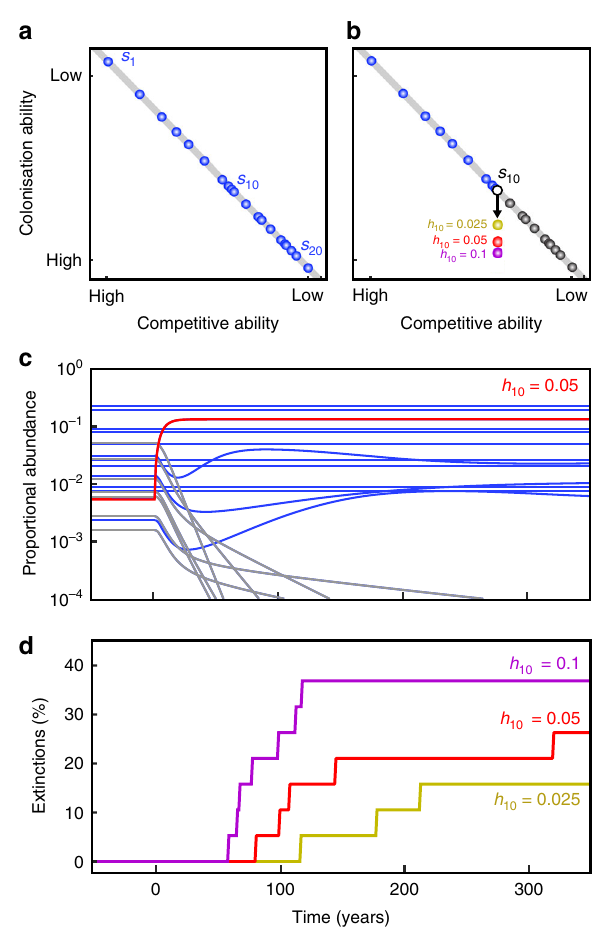
Fig. 1 Simulated species extinctions resulting from human-mediated species invasions. a Competition-colonisation tradeoff surface (grey line) of 20 coexisting species (blue circles) in a metacommunity, going from the best competitor ( s 1 ) to the worst competitor ( s 20 ). Species ’ competitive ranks are inverse to the rank order of species ’ colonisation abilities (this is the tradeoff). Note that, regardless of positions on the X -axis, differences in species ’ competitive abilities are determined by rank only such that the competitive difference between s 1 and s 2 is the same as the competitive difference between s 18 and s 19 . b Schematic drawing of disrupted tradeoff showing shifted position of designated “ invader ” ( s 10 , the intermediate competitor in the metacommunity, white circle indicates h 10 = 0) re fl ecting input of external colonists following Eq. 1 (i.e. increasing h 10 from 0 to 0.025 (yellow), 0.05 (red) and 0.1 (violet); shifted positions of s 10 on the fi gure were chosen to re fl ect the number of observed extinctions: 3 for h 10 = 0.025, 5 for h = 0.05 and 7 for h = 0.1); blue circles indicate “ native ” 10 10 species that are superior competitors and thus unaffected by the invasion; grey circles indicate the ten natives that could be displaced by s 10 . c Relative abundance (log scale) of each of the 20 species over time. Each line represents a species: the red line indicates the invader after elevating h 10 to 0.05; blue lines indicate persistent native species; grey lines indicate native species driven to extinction (i.e. relative abundance drops below 0.0001 of species ’ original equilibrium abundance) as a consequence of increasing h 10 . d A timeline of percentage of the 19 native species driven to extinction as a consequence of elevating h 10 to 0.025, 0.05 (same scenario shown in c ) and